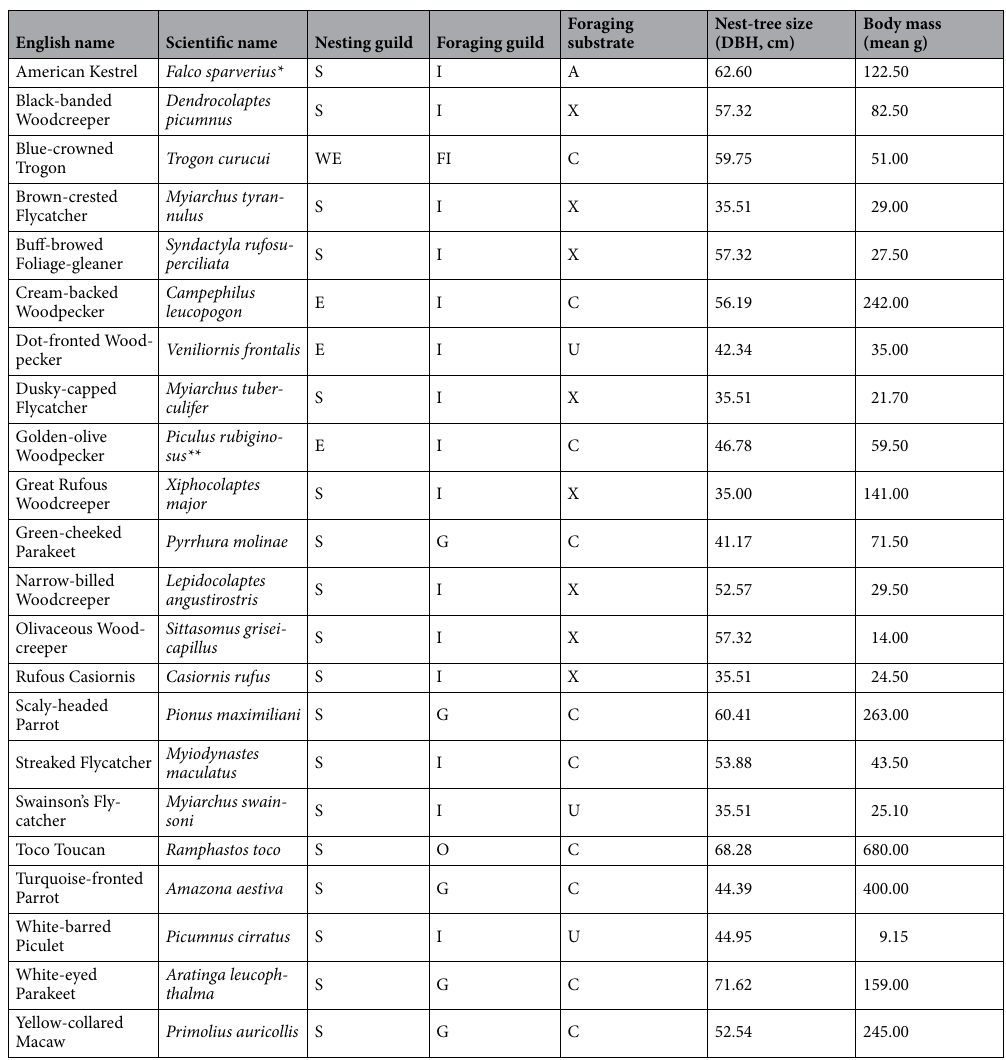
Table 1. Trait values used to measure functional diversity parameters for avian cavity-nesting species from subtropical piedmont forests in Argentina. Nesting guild: secondary-cavity nesters (S), weak cavity excavators (WE), strong primary excavator (E). Foraging guild: insectivore (I), frugivore–insectivore (FI), granivore (G), omnivore (O). Foraging substrate: air (A), bark (X), canopy (C), understory (U) 29,53 . ** Indicates species registered only in unlogged forest; * indicates those registered only in logged